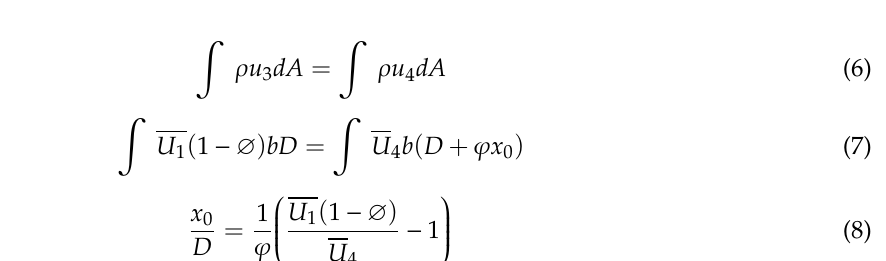
Figure 3. Flow chart of the main steps in the simulation.